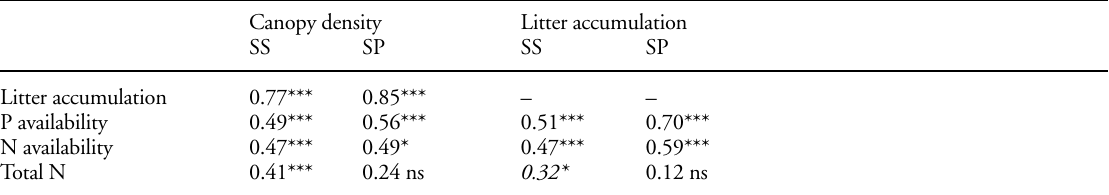
Table 2. Summary of the correlation values between canopy density, litter accumulation, and topsoil parameters in the two studied forests. For litter accumulation and canopy density, only the highest correlation found is shown. The per-test significance of the results is indicated by ns p>0.05, *: p ≤ 0.05, **: 0.05 < p ≤ 0.005, ***: p < 0.005. Values in italics did not remain significant after controlling the familywise error rate (FWER) in the entire correlation matrix at the 0.05 level. SS = Spanish site at Los Alcornocales Natural Park ; SP = Portuguese site at Sudoeste Alentejano e Costa Vicentina Natural Park .